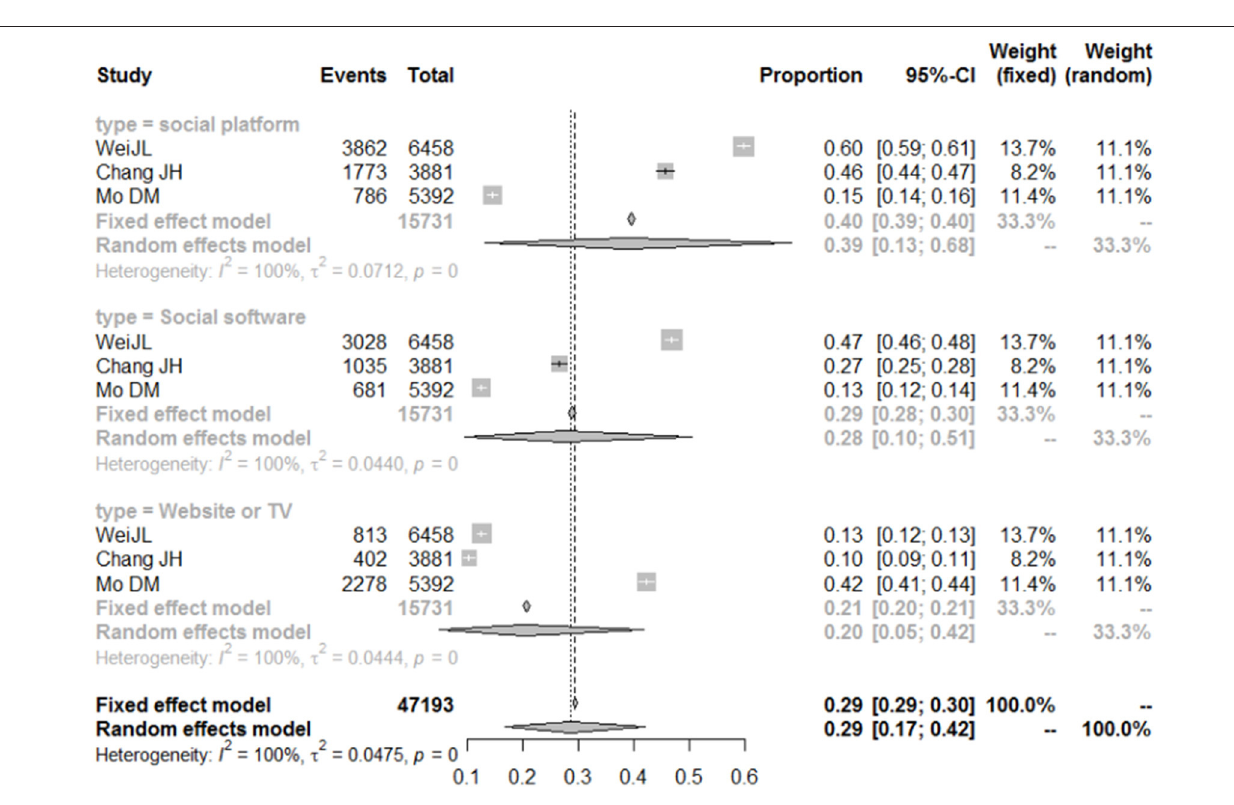
FIGURE 6 | Forest plot of the importance of different information platforms in disseminating COVID-19